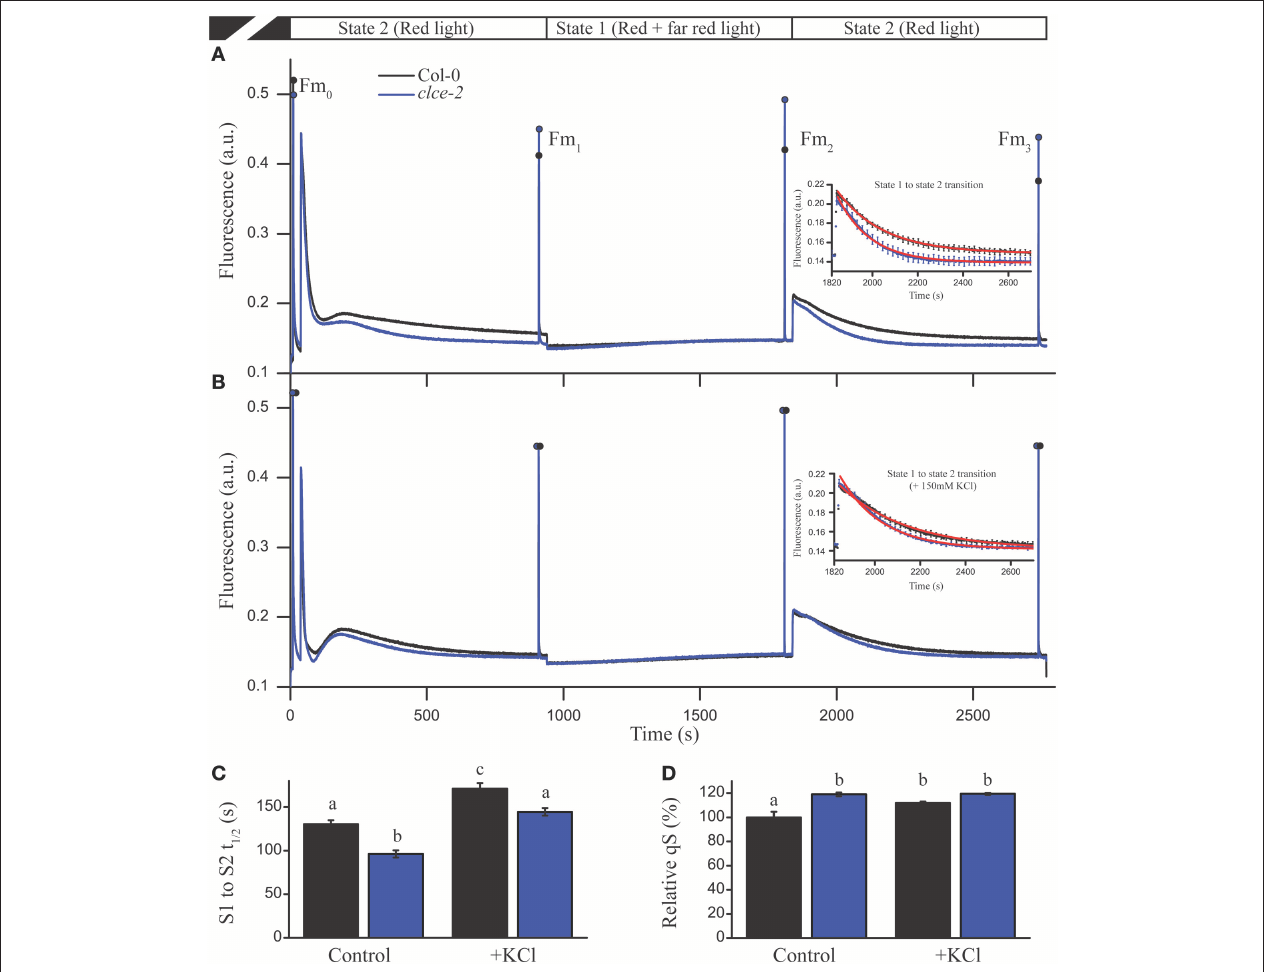
FIGURE 8 | State transition and light harvesting antenna changes in leaves. State transition measurements were performed in untreated (A) and KCl-treated (B) wild-type and mutant leaves. Insets represent state 1 to state 2 transition kinetics. (C) The halftime (t 1 / 2 ) of fluorescence relaxation from S1 to S2 was calculated by fitting an exponential decay function on the fluorescence signal shown in insets. (D) Relative values of qS parameter indicate the ability of the chloroplast to adjust electron transfer to changes in light quality. The plotted data are means ± SEM ( n = 4 –5 plants). Different letters in panels (C,D) indicate statistically significant differences (ANOVA, P < 0.05